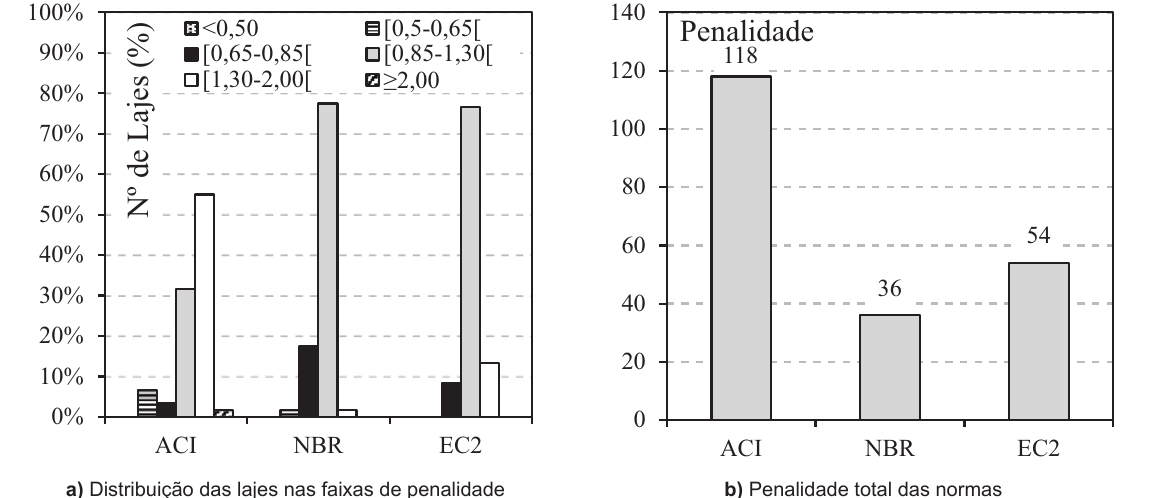
a) Distribuição das lajes nas faixas de penalidade b) Penalidade total das Figura 11 Desempenho das normas para lajes sem armadura de cisalhamento segundo o critério de Collins [23] A Figura 8 discute a influência da taxa de armadura de flexão ( ρ ) na resistência à punção. É possível perceber que o ACI 318 [10], ao ig- norar este parâmetro, tende a subestimar à resistência das lajes com